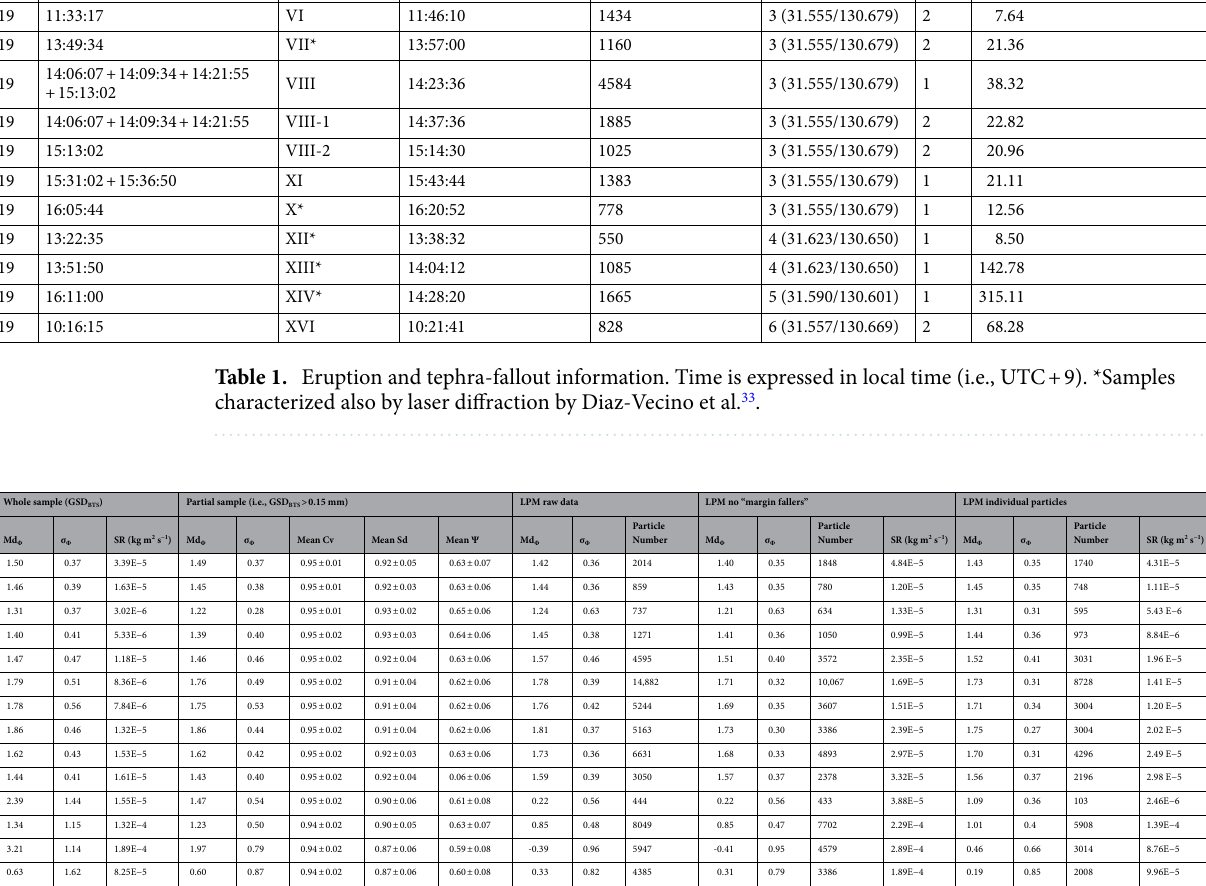
Table 2. Grain-size parameters as derived from both tephra samples (whole and partial) and LPM data. “Raw data”: LPM data without any filter. “No margin fallers”: LPM data without particles falling above the margin trend (see Fig. 3). “Individual particles”: LPM data without margin fallers and without particles falling below the individual-particle trend (see main text and Fig. 3 for more details). *Samples also analyzed by Diaz-Vecino et al. 33